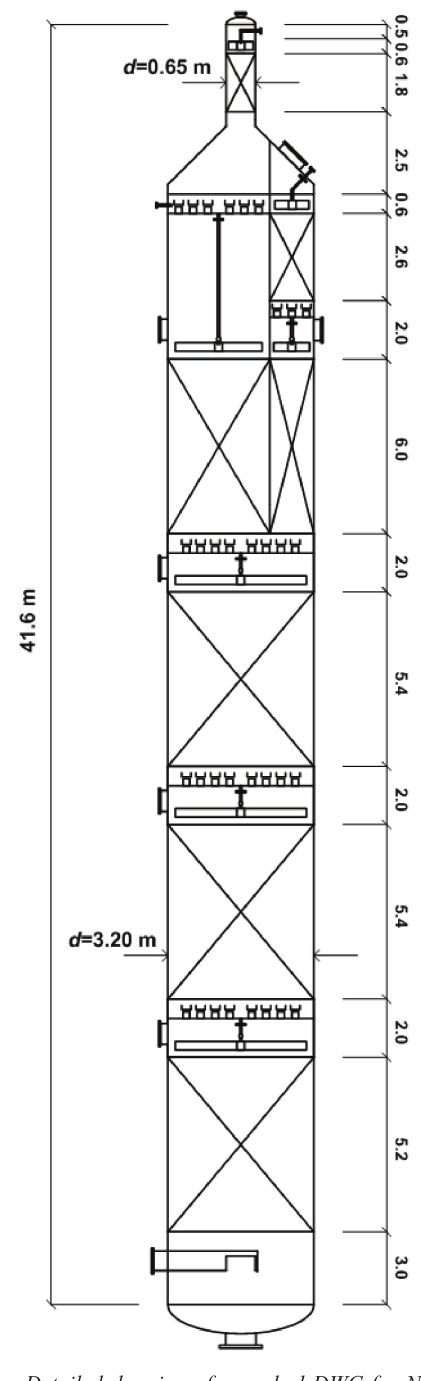
Fig. 4 – Detailed drawing of a packed DWC for NGL frac- tionation plant considered in this study